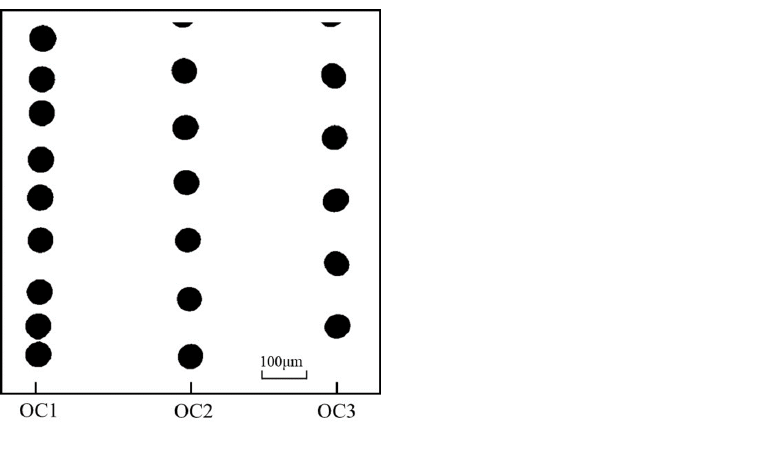
Figure 8. Snapshots of monodisperse droplets generated under three optimum conditions (OC1: 20 mL/h, 20 kHz; OC2: 30 mL/h, 30 kHz; and OC3: 40 mL/h, 40 kHz).